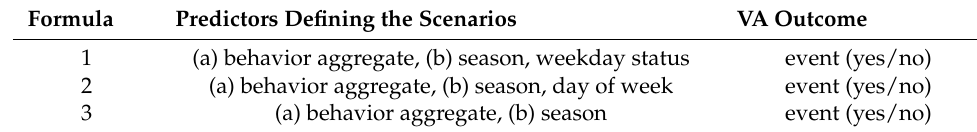
Table 3. Formulae, predictors, and outcome for conditional logistic regression.